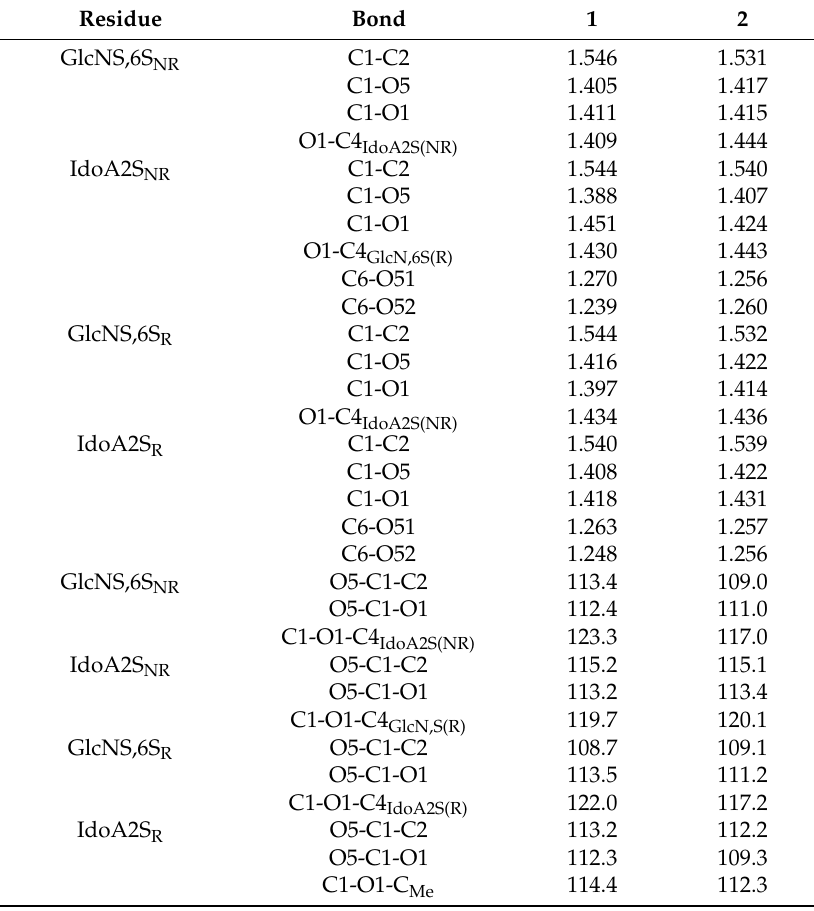
Table 1. Selected optimised (B3LYP/6-311++G(d,p)) interatomic distances (in Å) and bond angles (in degrees) in the heparin tetrasaccharide. Two conformers of the IdoA2S residues are considered: 1 C 4 ( 1 ) and 2 S 0 ( 2 ). The GlcNS,6S residues are in the 4 C 1